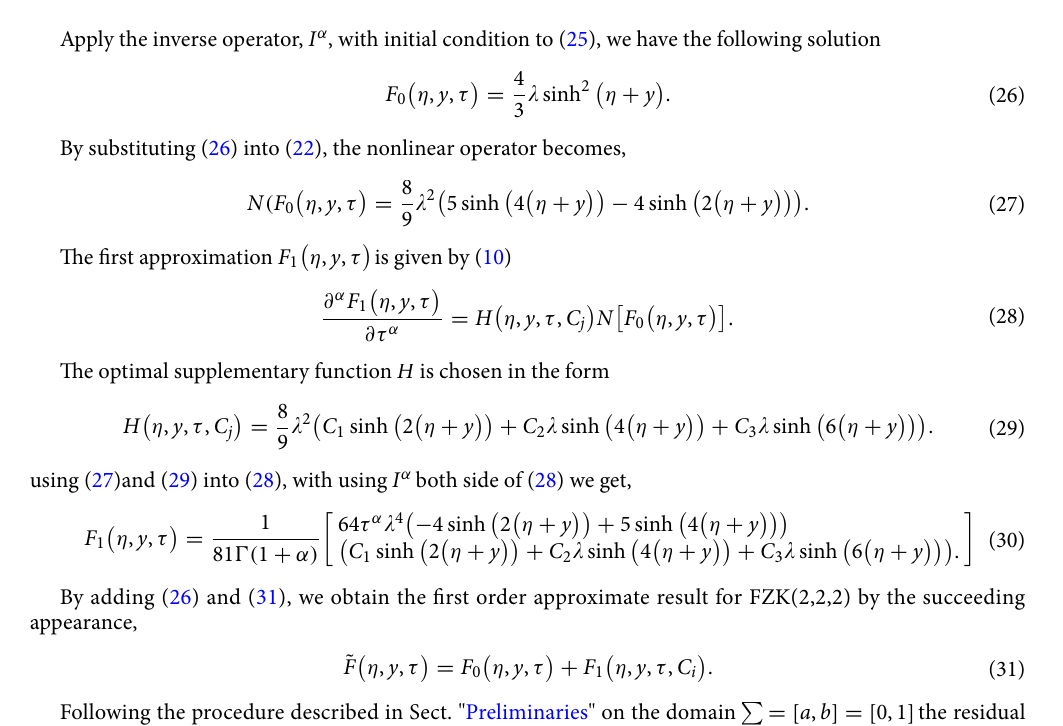
using (27)and (29) into (28), with using I α both side of (28) we get,